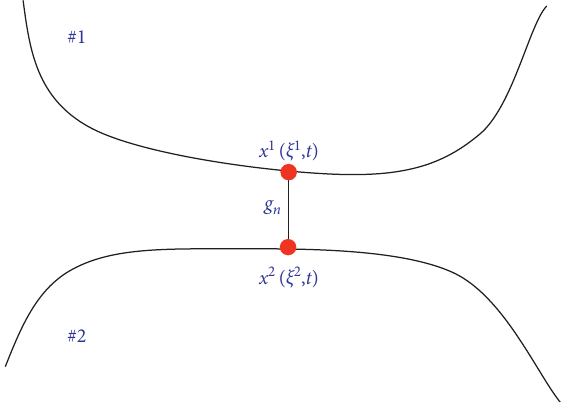
Figure 3: Contact relationship between the contact